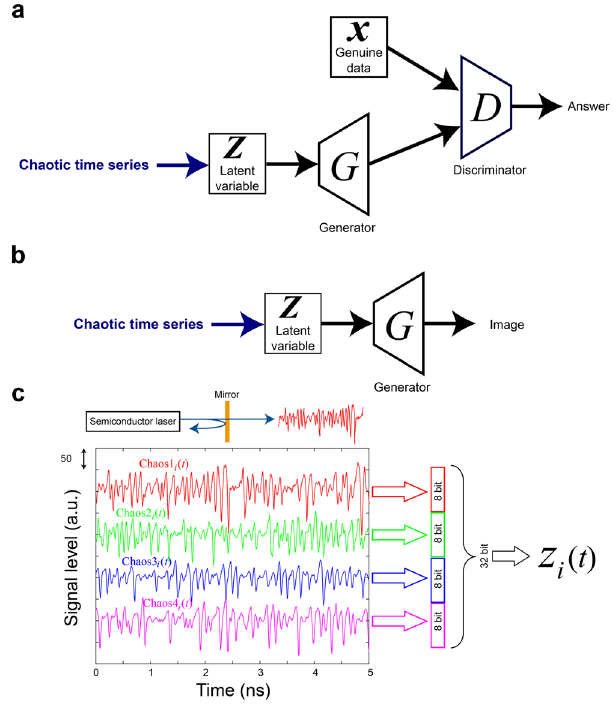
Figure 1. Use of chaotic sequences for GAN. ( a ) Use of chaotic time series in the training phase and ( b ) final data generation in the GAN. ( c ) Construction of latent variables from experimentally generated laser chaos